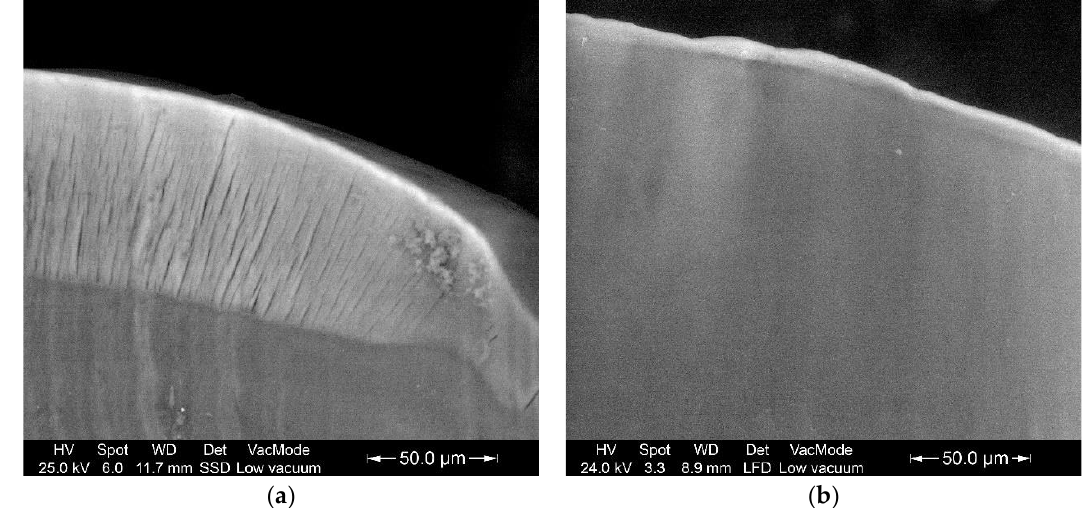
Figure 13. ( a ) Smooth cut edge detail; ( b ) detail of the rake face without texture. The cracks are due to drying of the specimen.